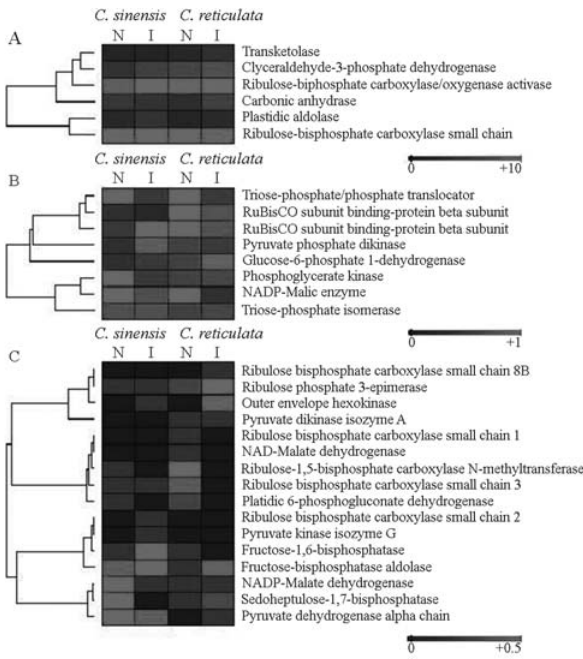
Figure 4 - Hierarchical clusterization by expression pattern of carbon fix- ation-relatedexpressedsequencesin C.sinensis and C.reticulata ,infected (I) or not infected (N) with Xylella fastidiosa . Black represents ‘no expres- sion’;lightgrayrepresents‘maximumexpression’withgrayintensitypro- portionally representing intermediate expression levels.